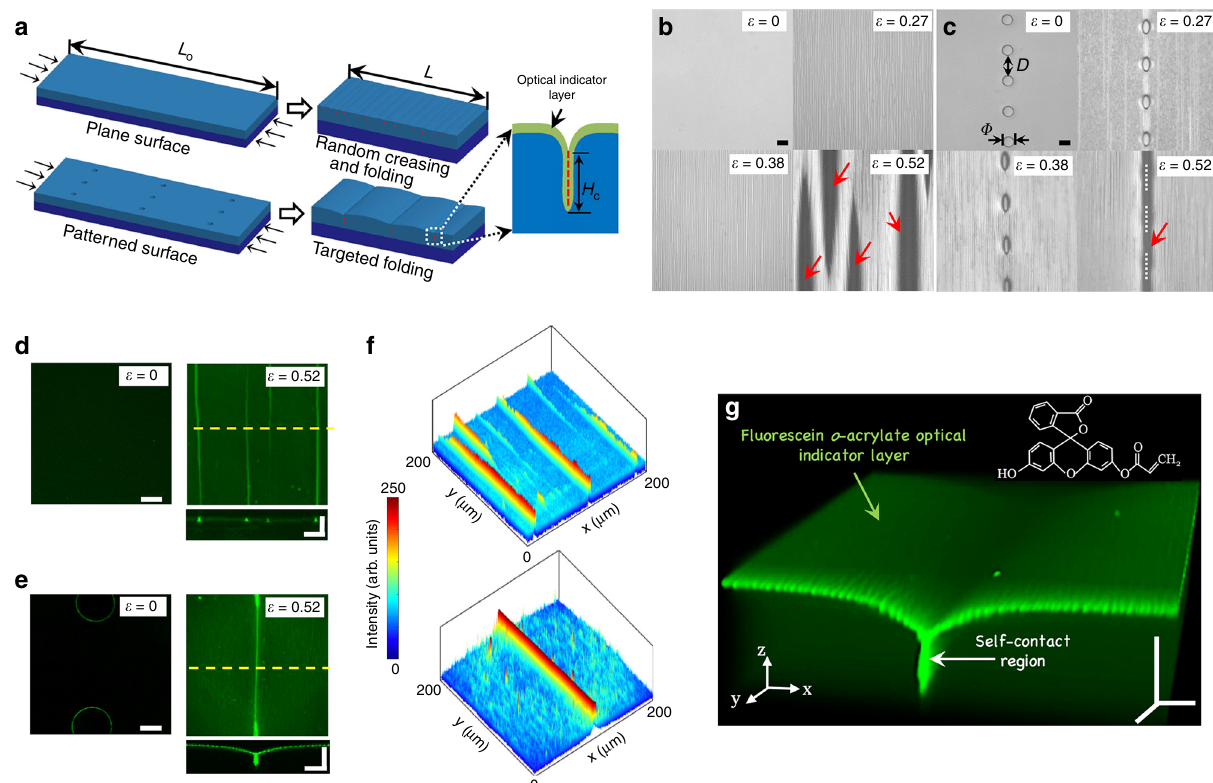
Fig. 1 The realization of topo-optical sensing. a Schematic illustrations and optical microscopic observations on the morphological changes on ( b ) plain surface and ( c ) surface patterned with single-line of micro-hole array ( Φ = 60 μ m, D = 120 μ m, h = 12 μ m, dot lines showing the location of closed holes) under compression. Laser scanning confocal microscopy (LSCM) images showing top and cross-sectional (for the dash lines in top view images) views of signals induced by ( d ) random folding on the plain surface, and ( e ) targeted folding on a micropatterned surface, with the digital analysed results for top view optical signals in ( f ). g A signal image of green opened book from 3D LSCM reconstruction to show the surface signal with targeted folding. All scale bars are 30 μ